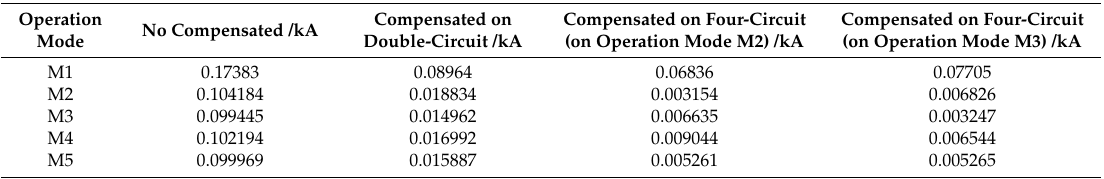
Table 3. Zero-Sequence differential current under different operation